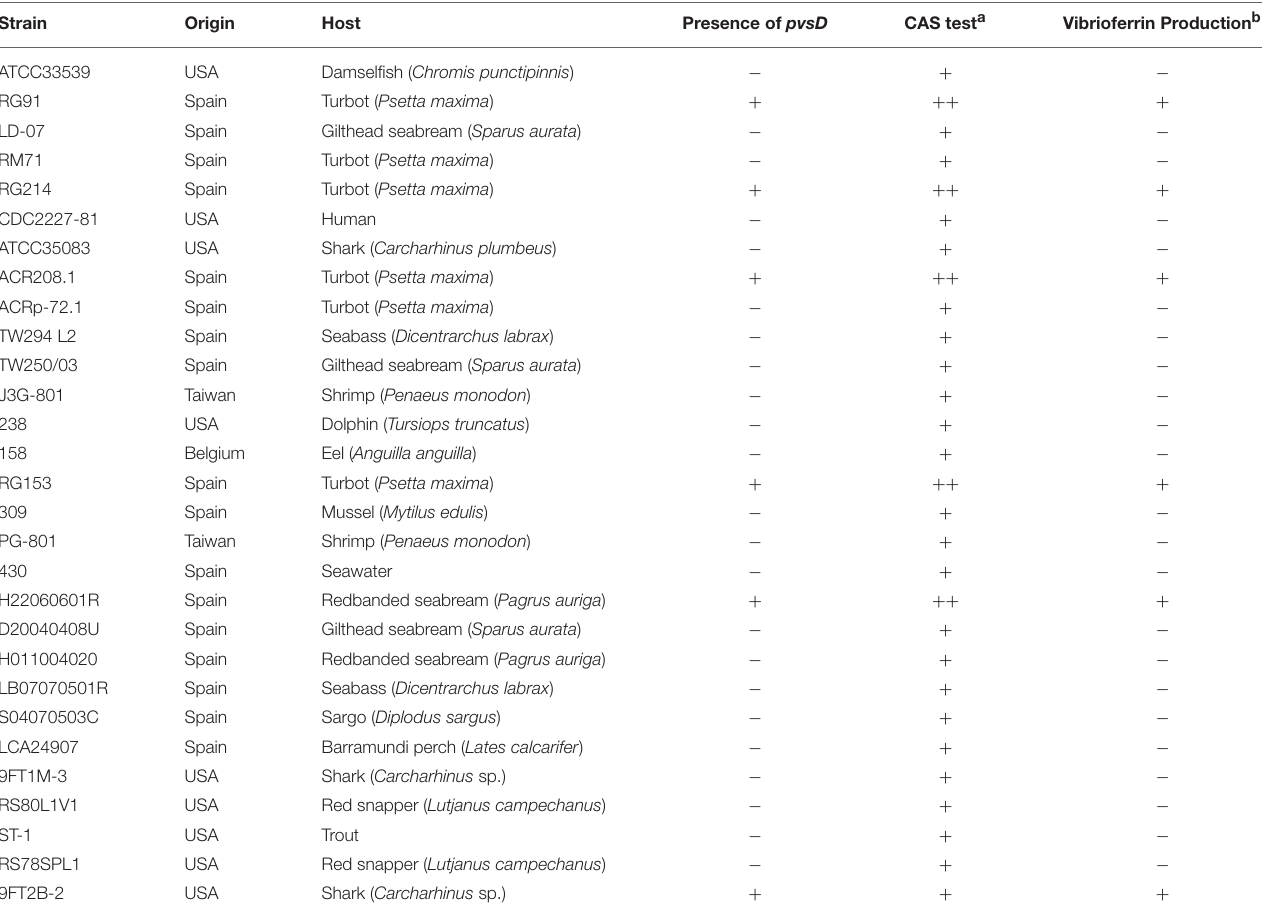
TABLE 3 | Results of the PCR assays to detect the presence of pvsD and results of the CAS test and bioassays to detect vibrioferrin production in a collection of Pdd strains. Strain Origin Host Presence of pvsD CAS test